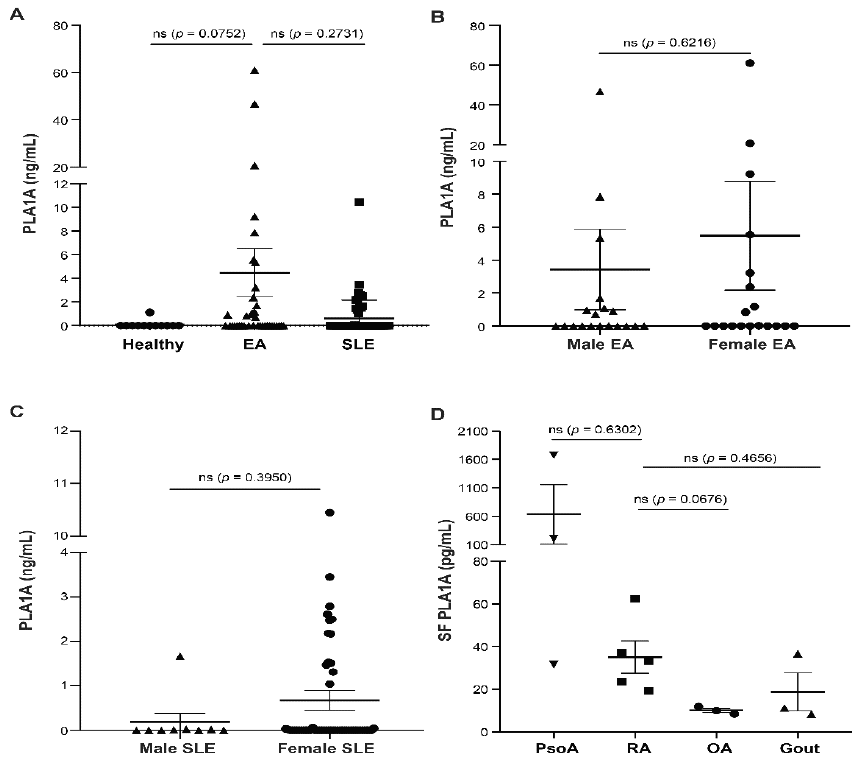
Figure 1. Concentrations of PLA1A in plasma and synovial fluids (SF) from arthritis patients and control donors. Concentrations of PLA1A in plasma and synovial fluids from RA patients and control groups were monitored using ELISA. ( A ) Human platelet-free plasma samples were collected from 12 healthy donors; 38 EA patients ( B ), including 19 males and 19 females); and 62 undergoing treatment SLE patients ( C ), including 9 males and 53 females. ( D ) Synovial fluid samples were collected from 3 PsoA patients, 5 RA patients, 3 OA patients, and 3 gout patients and were treated with 0.5 mg/mL hyaluronidase for 5 min at room temperature before measurement. For statistical comparative analyses, PLA1A concentrations in EA patient plasma were compared to that in healthy donors and in SLE patients. PLA1A concentrations in synovial fluid of RA patients were compared to that in PsoA, OA, and gout